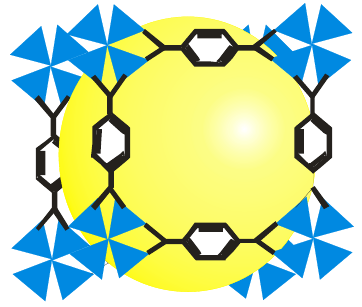
Figure 4. Structure of typical metal–organic frameworks used for gas storage.